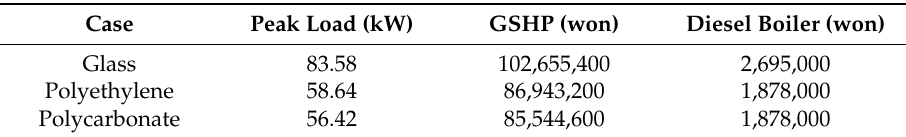
Table 6. Initial cost of each system.